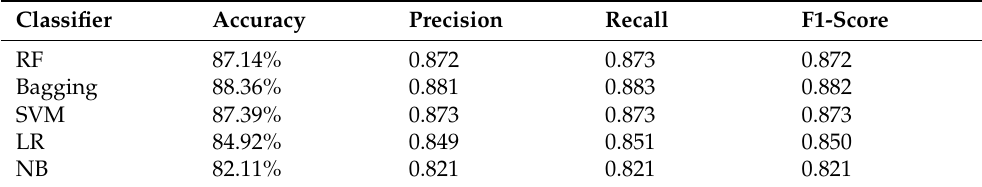
Table 30. Performance results of ML models using the under-sampling dataset and the concatenated features and all